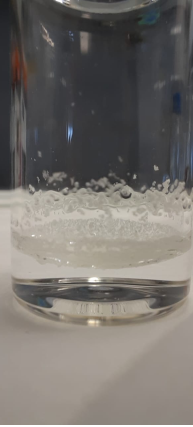
Figure A4. Photograph of CBD (20mg/mL) dissolved in purified water. It can be clearly seen that the CBD does not dissolve in water. Rather, it sticks as a gel-like substance on the glass